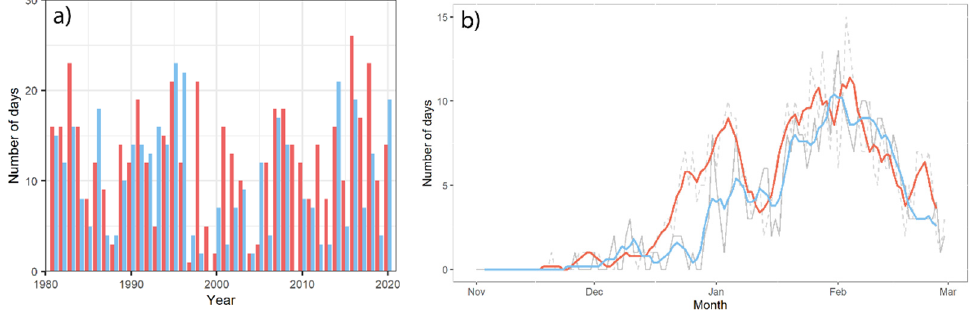
Figure 2. The variability of the total number of days with EPz e : ( a ) interannual variability (red bars indicate upward EPz e and blue bars downward EPz e ) and ( b ) intra-seasonal variability (the grey dashed line shows upward EPz e and the red line indicates a 5-day moving average. The grey solid line shows downward EPz e and the blue line indicates a 5-day moving average), 1981–2020 NDJF.